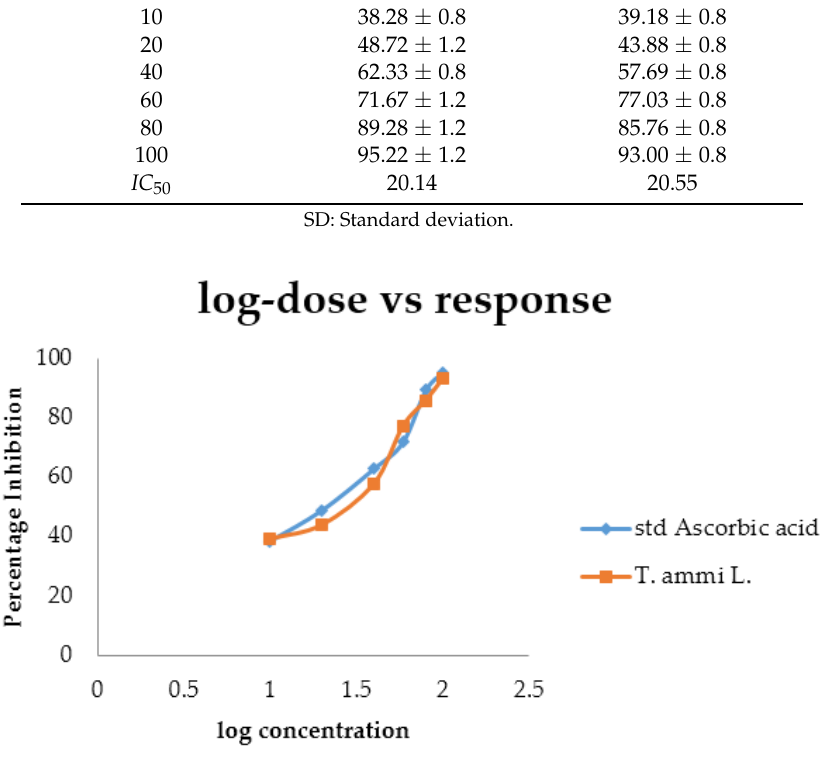
Figure 8. Comparative dose response curve between percent inhibitions against log concentration by the superoxide scavenging method.